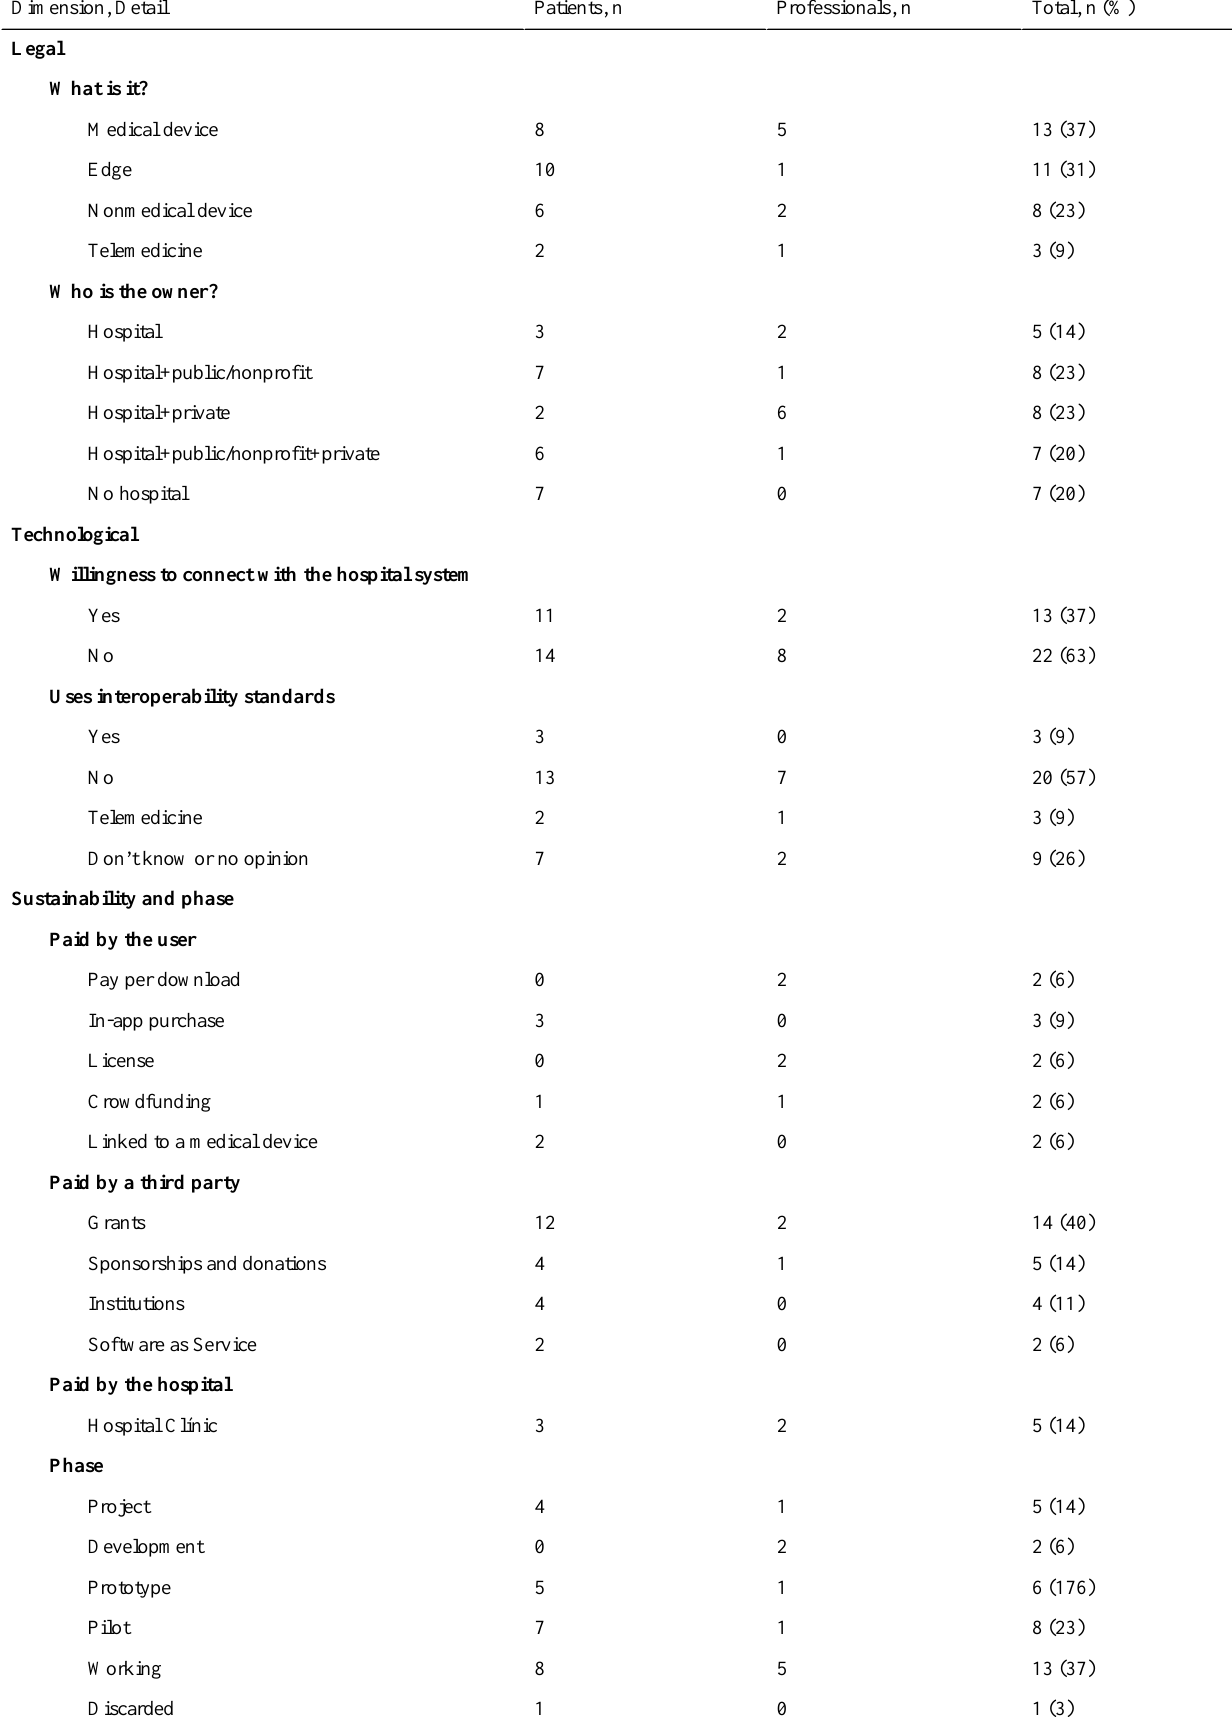
Table 3. Legal, technological, sustainability, and patient participation aspects adapted from the Mobile Health 5 Dimensions European